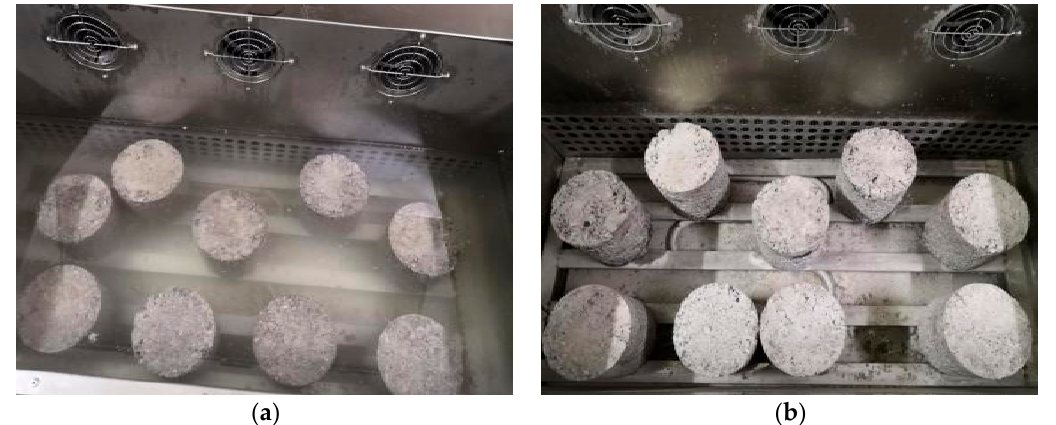
Figure 9. Freezing and thawing process: ( a ) Fused specimen; ( b ) Frozen test piece.